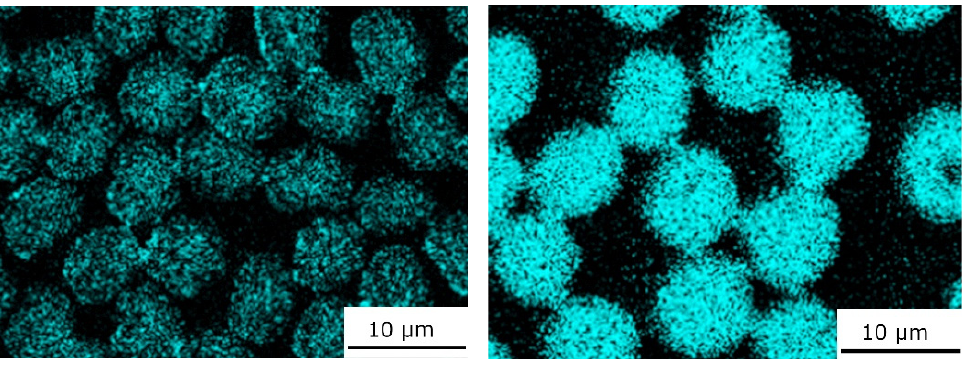
Figure 11. EDX oxygen distribution of Mg2Li/T300 ( left ) and Mg2Li/Granoc ( right ) composites.